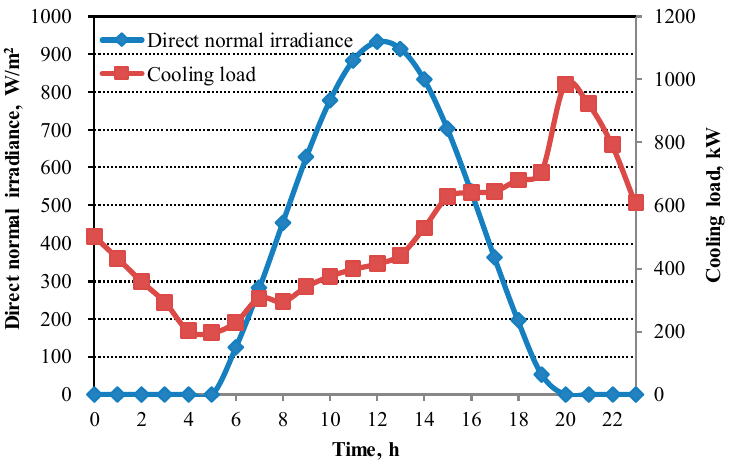
Figure 8. Hourly cooling loads and solar DNI in a typical day.